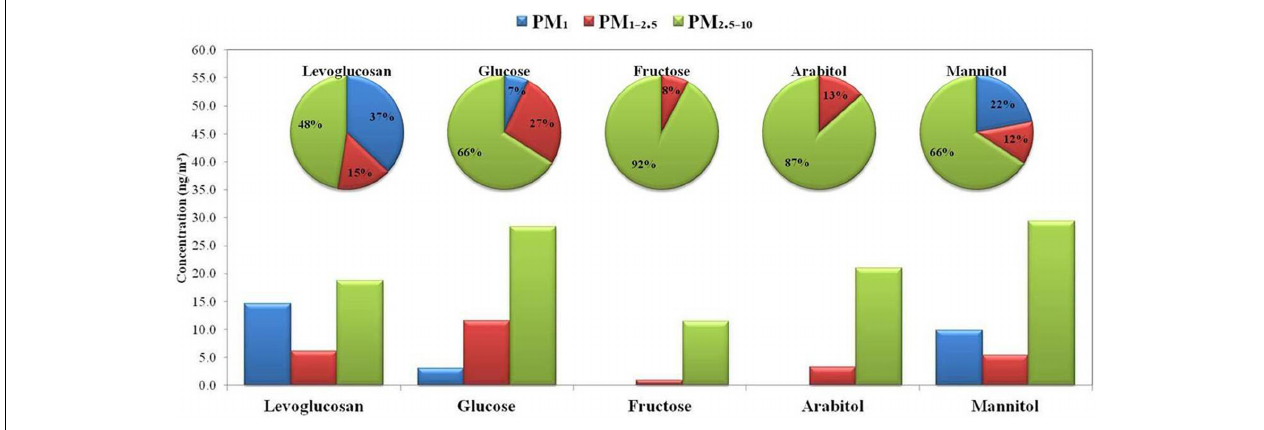
FIGURE 8 | Size distributions and contributions of the saccharide